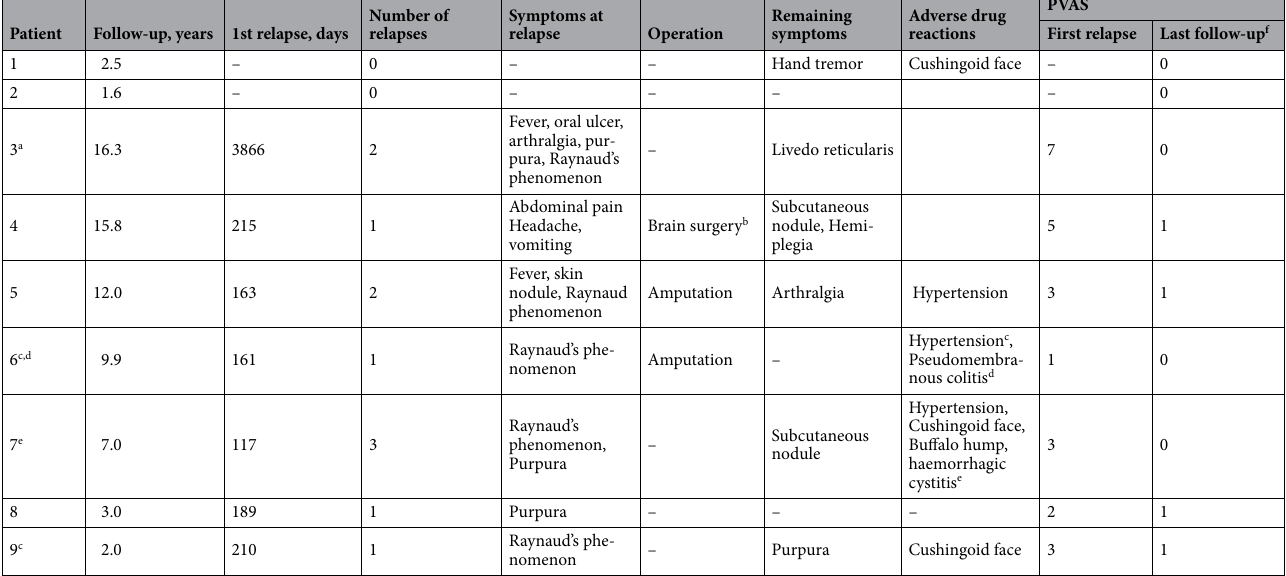
Table 3. Major events during follow-up. Major events during the follow-up for the nine patients. a Patient 3 maintained high-dosed steroids due to worsening symptoms upon steroid reduction, and the period before entering maintenance treatment was 599 days. b Craniotomy and intracerebral hematoma evacuation were done due to intracranial haemorrhage. c Oral cyclosporin A was used for maintenance and was stopped because of hypertensive encephalopathy. d Diarrhoea occurred 30 days after the start of steroid treatment, and was found to be due to pseudomembranous colitis. e The first treatment as well as the treatments at the first recurrence and second recurrence included cyclophosphamide pulse therapy, and at the third recurrence, the patient developed haemorrhagic cystitis after the cyclophosphamide pulse therapy. f PVAS was not scored as PVAS new/worse, but as PVAS